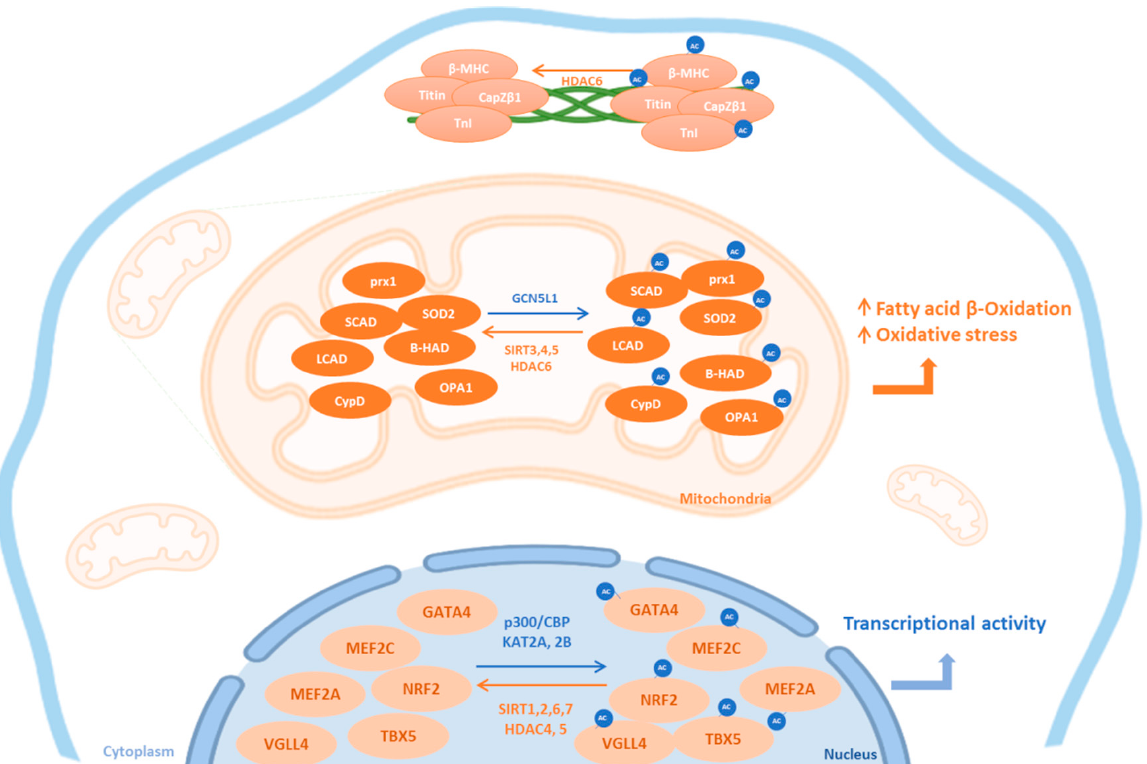
Figure 1. Subcellular localization of cardiac KATs and KDACs. This figure summarizes the subcellular localization of the most common lysine acetyltransferases (KATs, blue) and lysine deacetylases (KDAC, orange) and their cardiac targets. Ac: acetylated form; HDAC: histone deacetylase; SIRT: sirtuins; β -MHC: beta-myosin heavy chain; TnI: Troponin I; prx1: peroxiredoxin 1; LCAD: long chain acyl CoA dehydrogenase; SCAD: short chain acyl CoA dehydrogenase; β -HAD: L-3-hydroxy acyl-CoA dehydrogenase; SOD2: superoxide dismutase 2; CypD: Cyclophilin D; OPA1: optic atrophic 1; TBX5: T-Box transcription factor 5; VGLL4: vestigial-like 4; GATA4: GATA-binding factor 4; MEF: myocyte enhancer factor; Nrf2: nuclear factor erythroid-2-related factor 2; GCN5L1: general control of amino acid synthesis 5 like-1; CBP: CREB binding